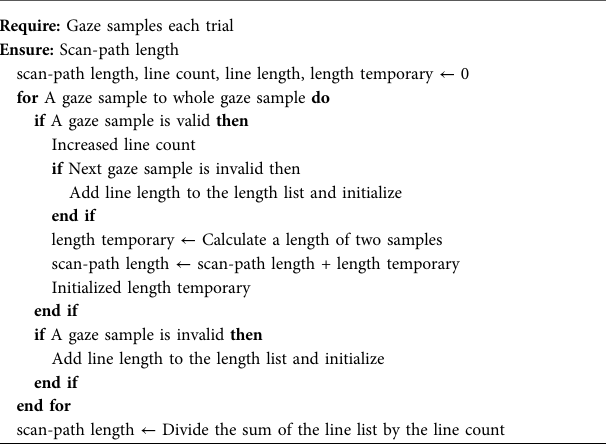
Algorithm 1 Calculation of scan-path